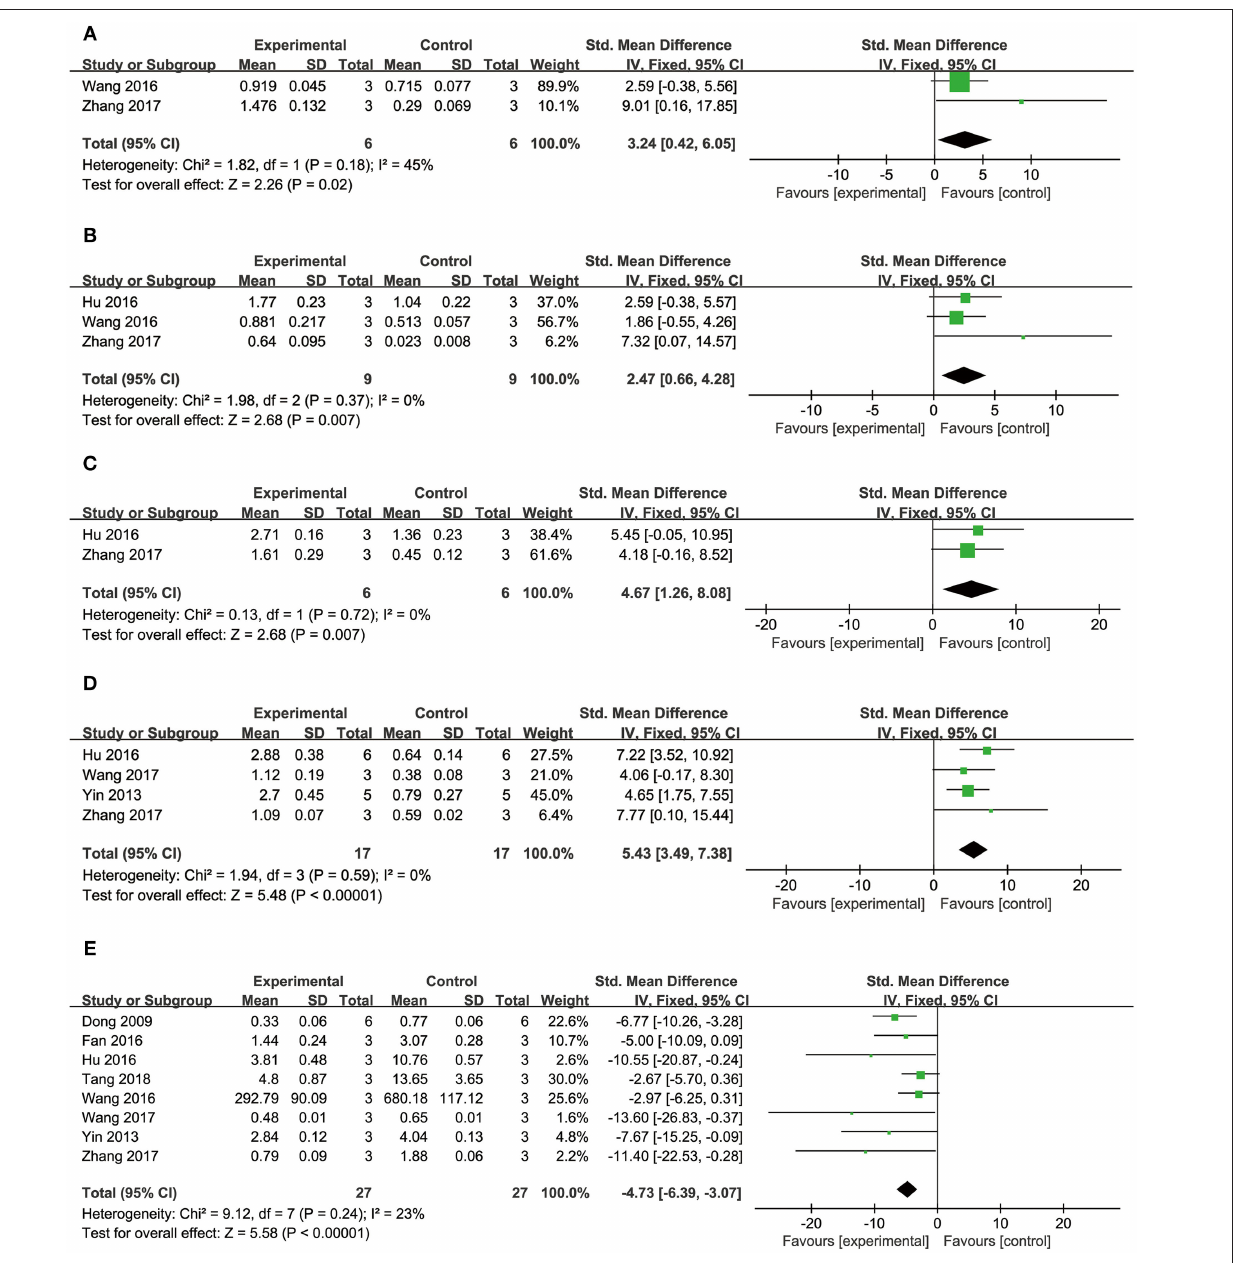
FIGURE 7 | The forest plot: (A) in vitro effects of danshensu for increasing PGC1- α compared with controls ( n = 6 per group); (B) in vitro effects of danshensu for increasing Nrf2 compared with controls ( n = 9 per group); (C) in vitro effects of danshensu for increasing HO-1 compared with controls ( n = 6 per group); (D) in vitro effects of danshensu for increasing Bcl-2/Bax compared with controls ( n = 17 per group); (E) in vitro effects of danshensu for reducing caspase-3 compared with controls ( n = 27 per group). PGC1- α , peroxisome proliferator activated receptor γ coactivator-1 α ; Nrf2, nuclear factor erythroid 2-related factor 2; HO-1, heme oxygenase-1; Bcl-2/Bax, B-cell lymphoma-2/BCL2-associated X